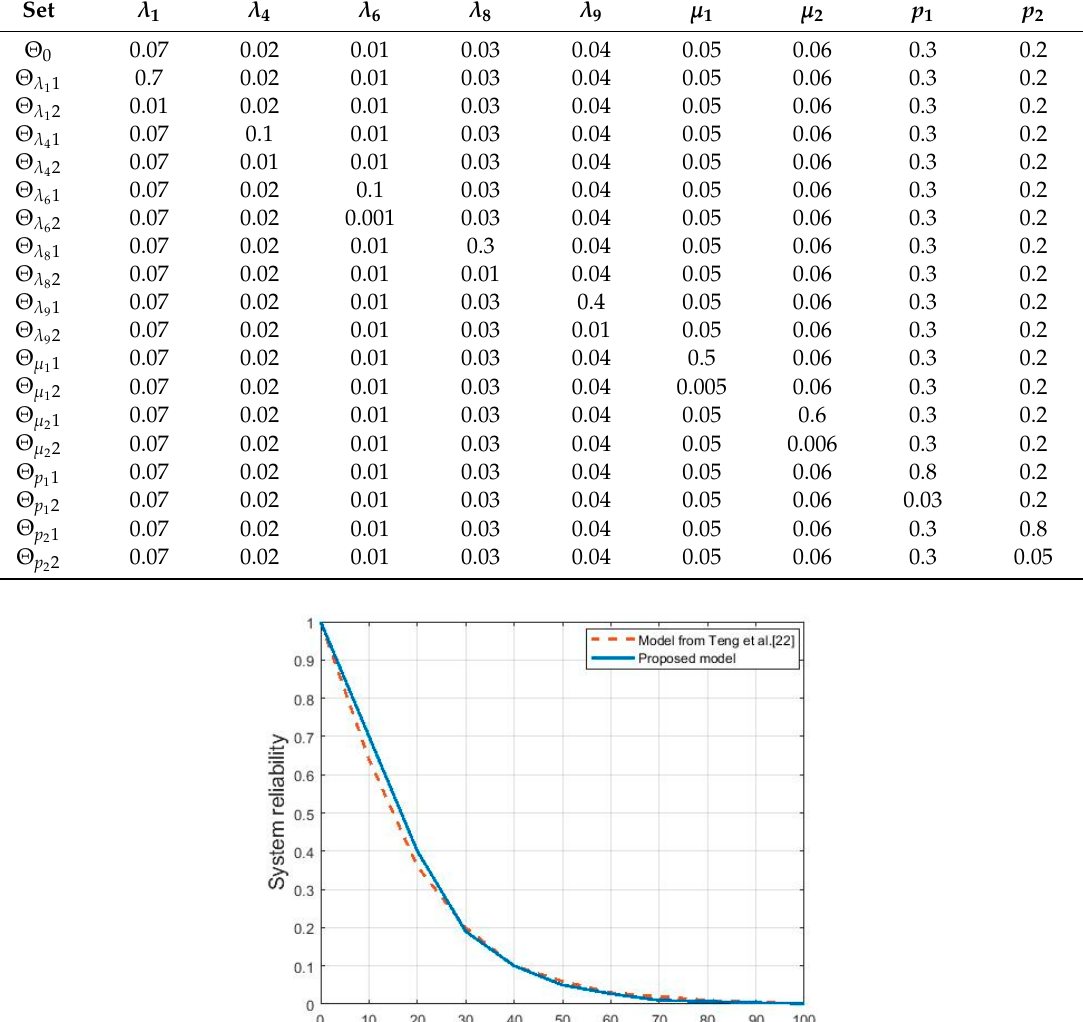
Table 1. Different transition parameter sets Θ (cid:3020) Table 1. Di ff erent transition parameter sets Θ S